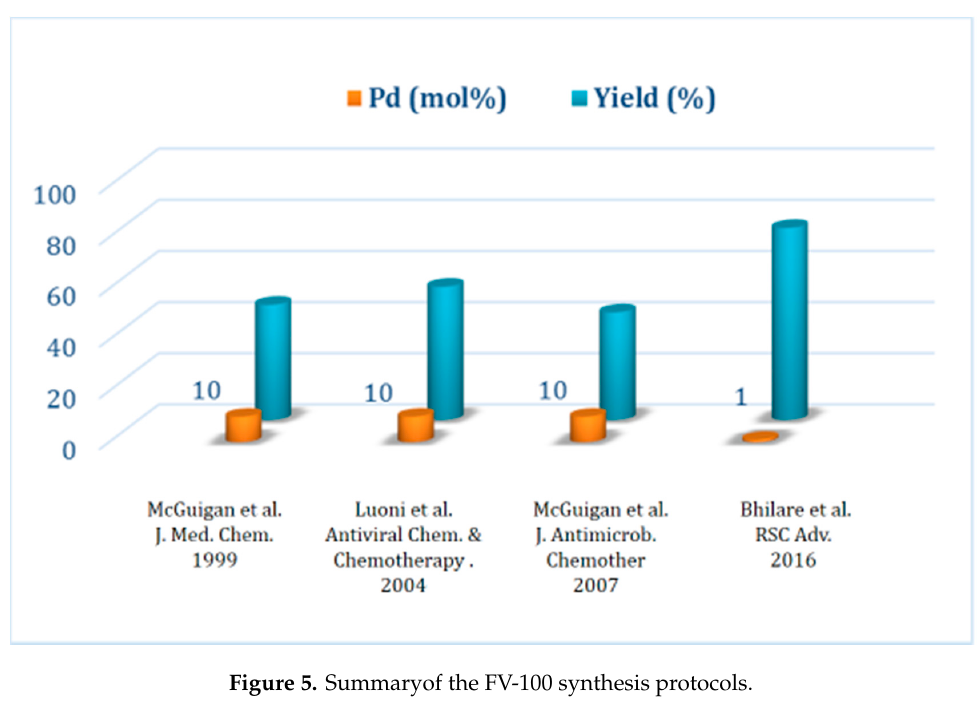
Figure 5. Summaryof the FV-100 synthesis protocols.